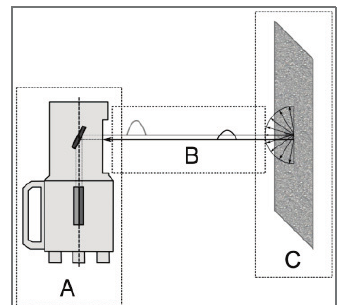
Figure 1. Classification of effects on the laser signal